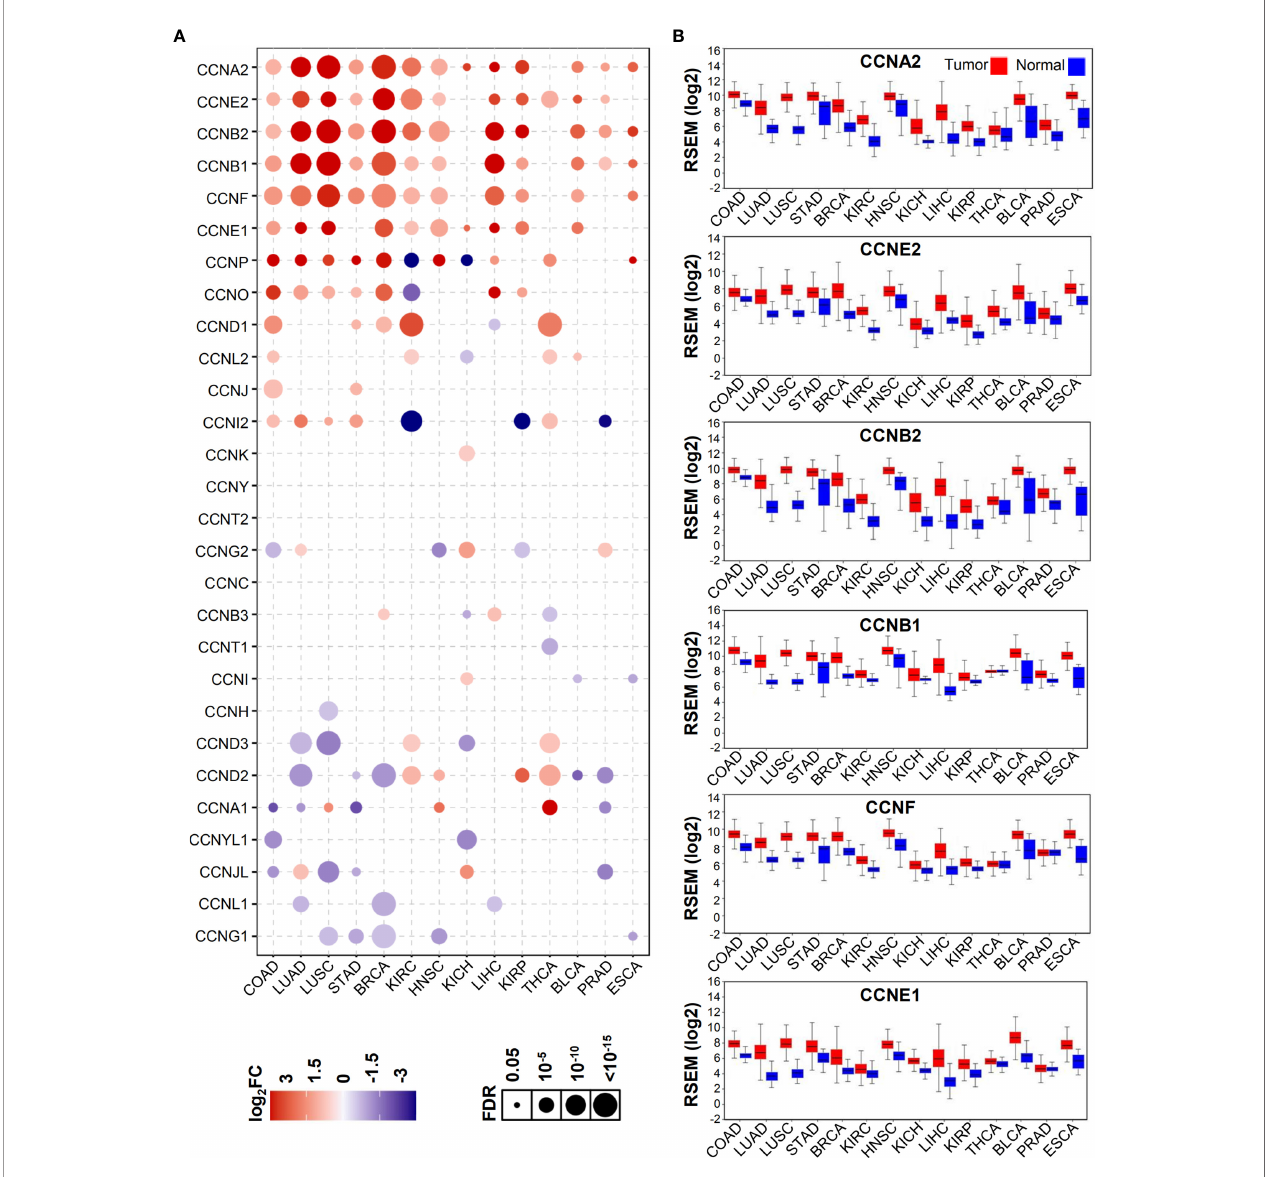
FIGURE 1 | Expression patterns of cyclin family genes between normal and tumor tissues of patients with different cancers. (A) The bubble plot shows the expression levels of all cyclin family genes in 14 cancers from GSCA. FC, fold change; FDR, false discovery rate. (B) Boxplots of the top six genes in (A) from